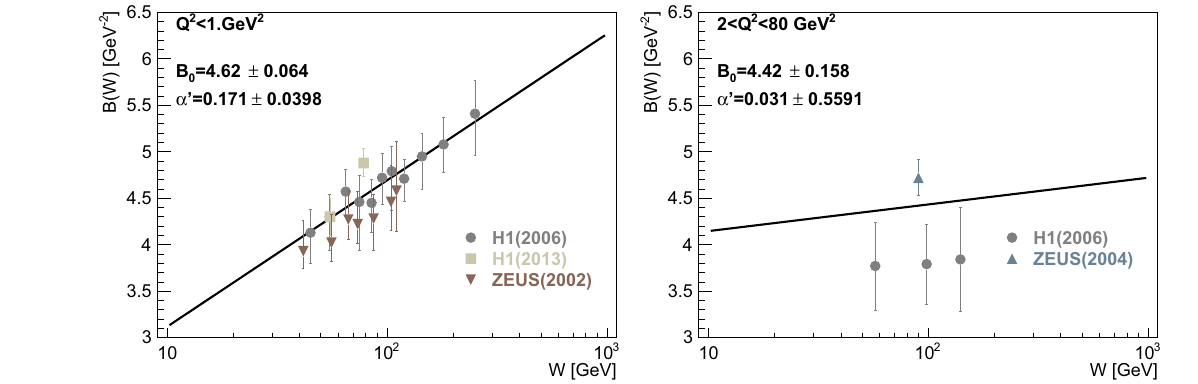
Fig. 6 The dependence of the diffractive slope on c.m. energy B ( W )